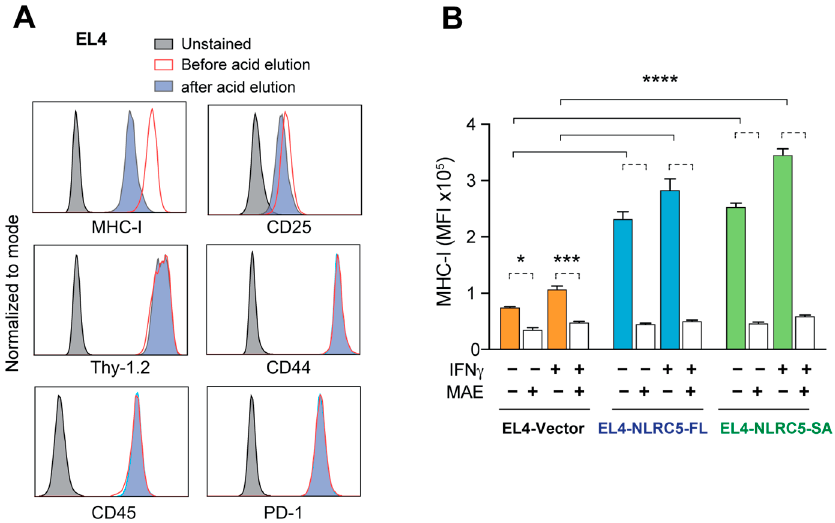
Figure 3. Loss of MHC-I expression in EL4-NLRC5-SA cells following elution of MHC-I-associated peptides (MAPs). ( A ) Selective destabilization of MHC-I expression by acid elution of MAPs. Parental EL4 cells were incubated with citrate phosphate buffer for 2 min, and the expression of MHC-I and the indicated cell surface markers was examined by flow cytometry. Representative data from three experiments are shown. Untreated (red) and unstained samples (grey) cells were used as controls. ( B ) Loss of MHC-I upon acid elution in NLRC5-expressing EL4 cells. EL4 cells expressing empty vector, NLRC5-FL or NLRC5-SA, stimulated or not with 20 ng/mL mIFN γ for 24 h, were subjected to acid elution, and MHC-I expression was measured by flow cytometry. MFI, Mean fluorescence intensity. Mean and standard deviation from three experiments. Turkey’s multiple comparison test: * p ≤ 0.05, *** p ≤ 0.001, **** p ≤ 0.0001.